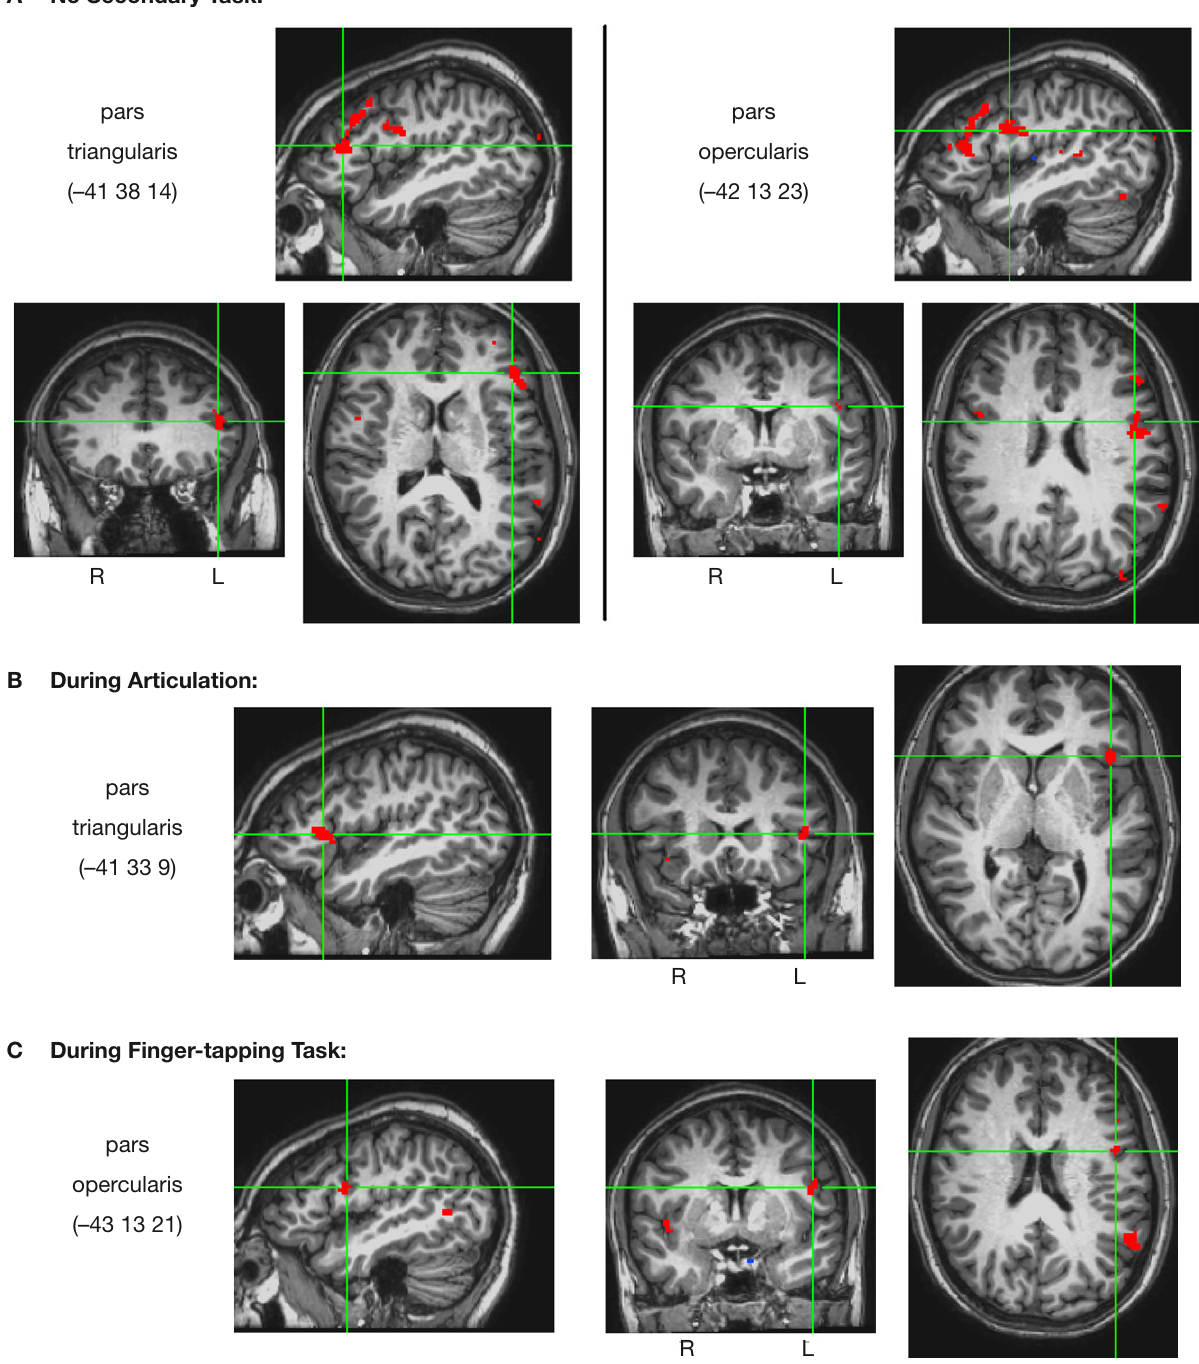
Figure 5 | Left inferior frontal voxel clusters more active during the presentation of object-relative clause sentences than subject-relative clause sentences ( p < 0.005). Clusters shown are those meeting these criteria while subjects were performing (A) no secondary task, (B) articulation, or (C) a fi nger- tapping task. Talairach coordinates for peak activity in each cluster are